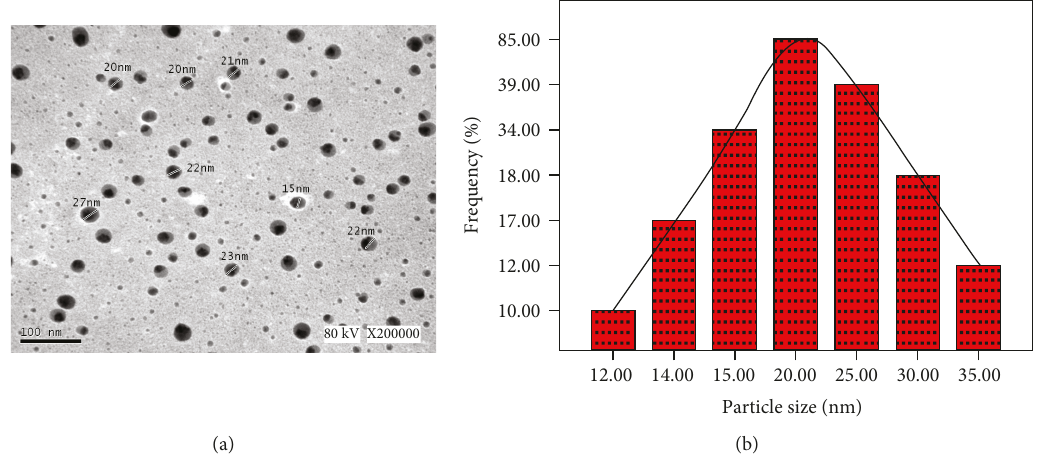
Figure 2: (a) TEM image of Ag-NPs and (b) histogram of size distribution.